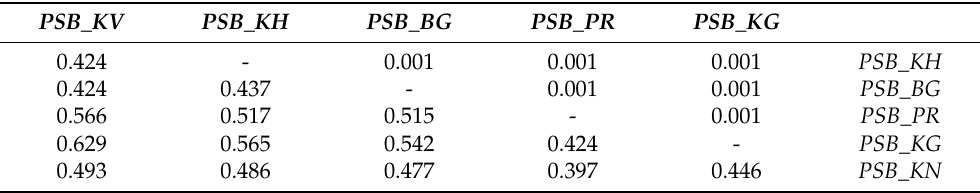
Table 7. Paired PhiPT genetic distances between the studied populations of P. sibirica by